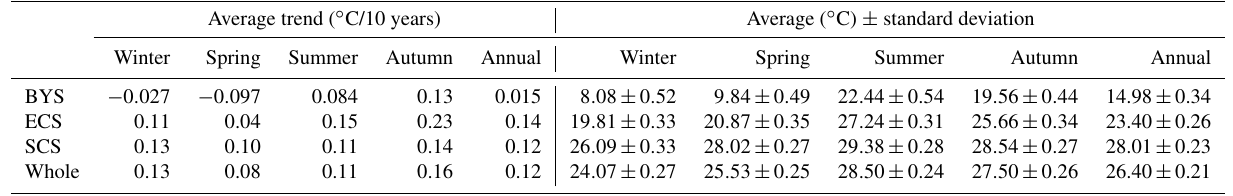
Table 2. Annual and seasonal SST characteristics of the study area in China offshore based on monthly data from 1988 to 2017. Average trend ( ◦ C/10 years)